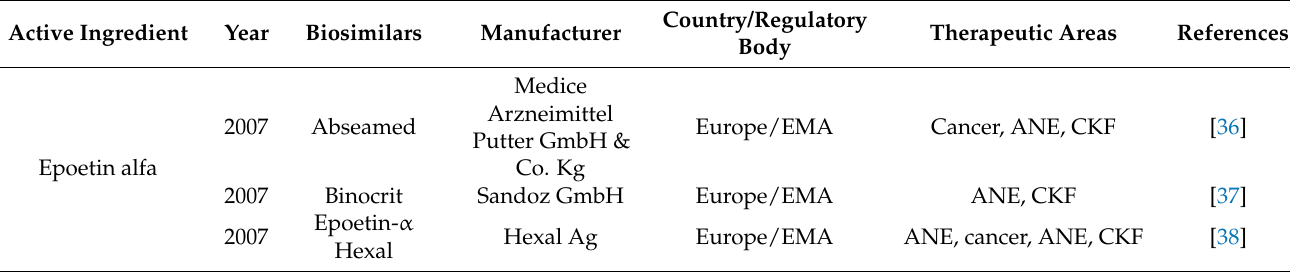
Table 1. Recently approved biosimilars in